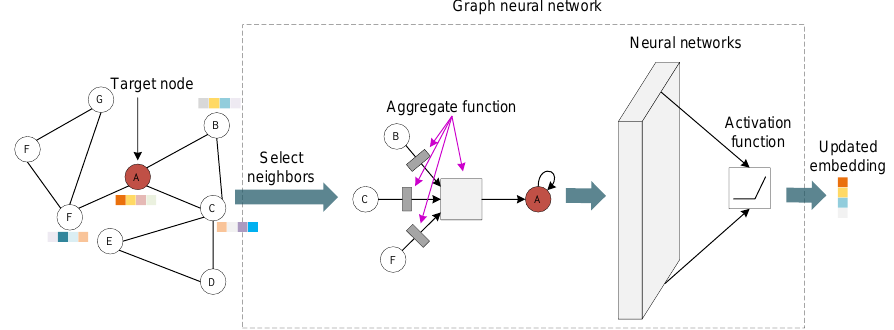
Figure 5. A typical and basic architecture and processing procedures of GNN. First, GNN selects neighbors with a certain strategy. Then, an aggregate function is applied to extract information around the central node. At last, the aggregated information passes through a neural network to be performed nonlinear transformation. The output is updated representation of central